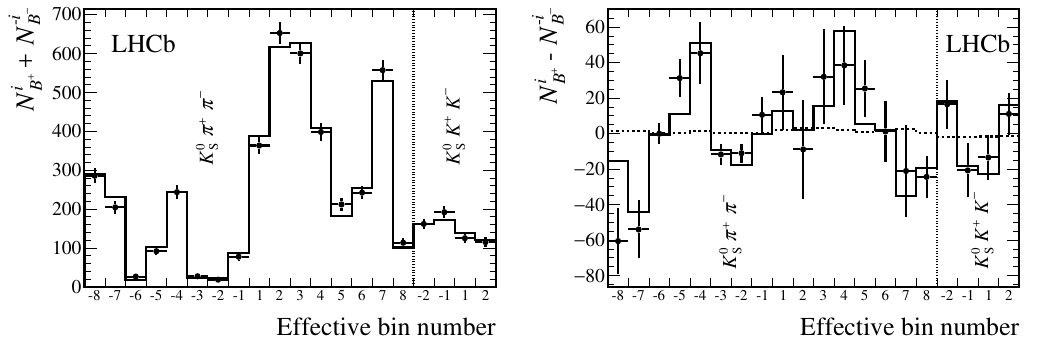
Figure 8 . (Left) Comparison of total signal yields from the direct (cid:12)t (points) to those calculated from the central values of x (cid:6) and y (cid:6) (solid line). The yields are given for the e(cid:11)ective bin: + i for B + and (cid:0) i for B (cid:0) , and summed over B charge and K 0 decay category. (Right) Comparison of the S